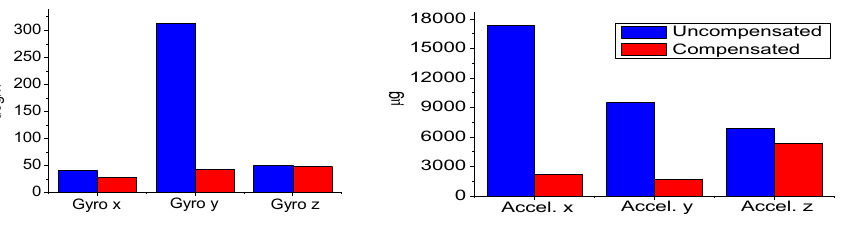
Figure 15. RMS values of NV-IMU100 output errors with and without